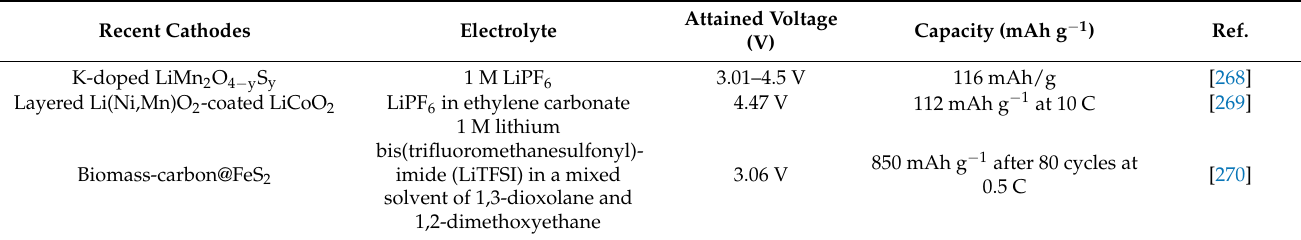
Table 5. Recent electrolytes, cathodes, and capacities observed in Li-based batteries. Attained Voltage Recent Cathodes Electrolyte